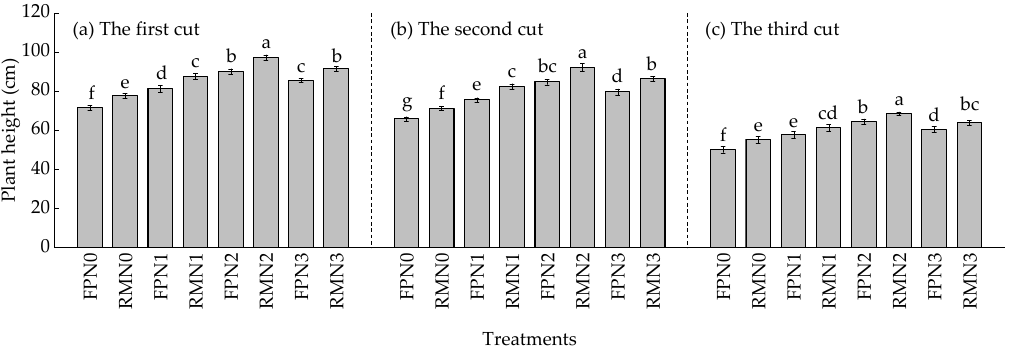
Figure 3. Impact of planting pattern and nitrogen level on the plant height of alfalfa. FP and RM refer to conventional flat planting and ridge culture with film mulching, respectively. N0, N1, N2, and N3 refer to nitrogen application rates of 0 kg·ha − 1 , 80 kg·ha − 1 , 160 kg·ha − 1 , and 240 kg·ha − 1 . Different lowercase letters indicate significant difference among treatments ( p < 0.05).